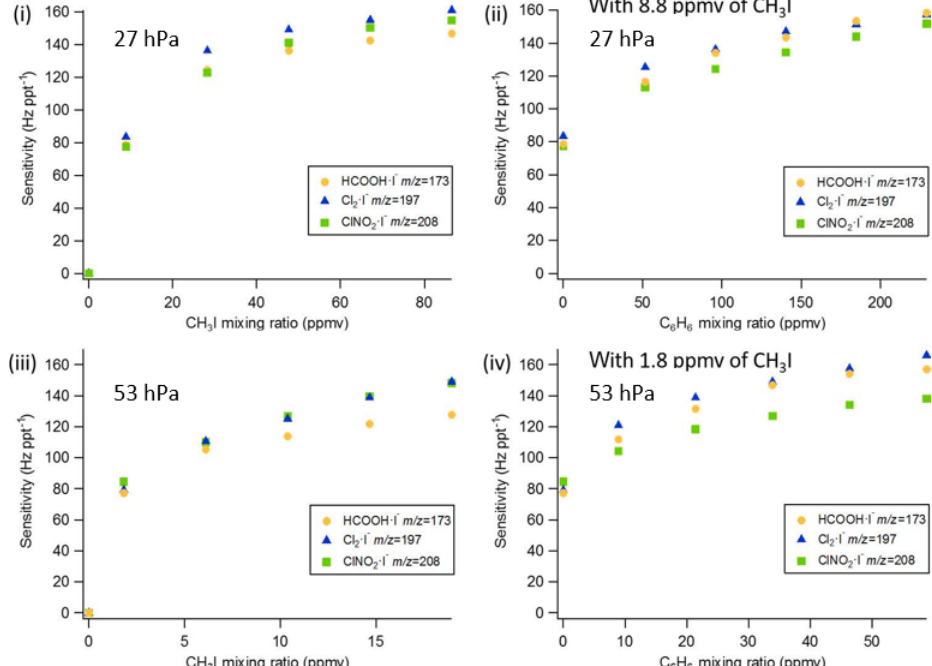
Figure 3. Q-CIMS using VUV-IS configuration (b): (i) sensitivity as a function of CH 3 I at 27hPa, (ii) sensitivity as a function of C 6 H 6 at 27hPa with 8.8ppmv of CH 3 I, (iii) sensitivity as a function of CH 3 I at 53hPa, and (iv) sensitivity as a function of C 6 H 6 at 53hPa with 1.8ppmv of CH 3 I.